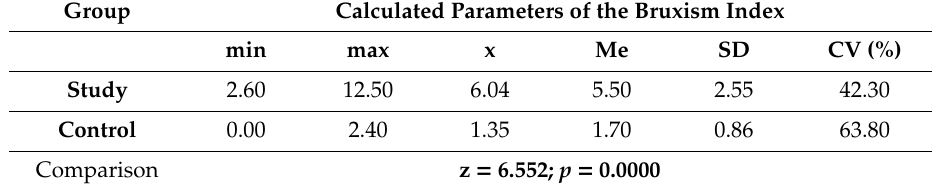
Table 3. Comparison of the average values of the bruxism index in patients from the study group and in the control group.